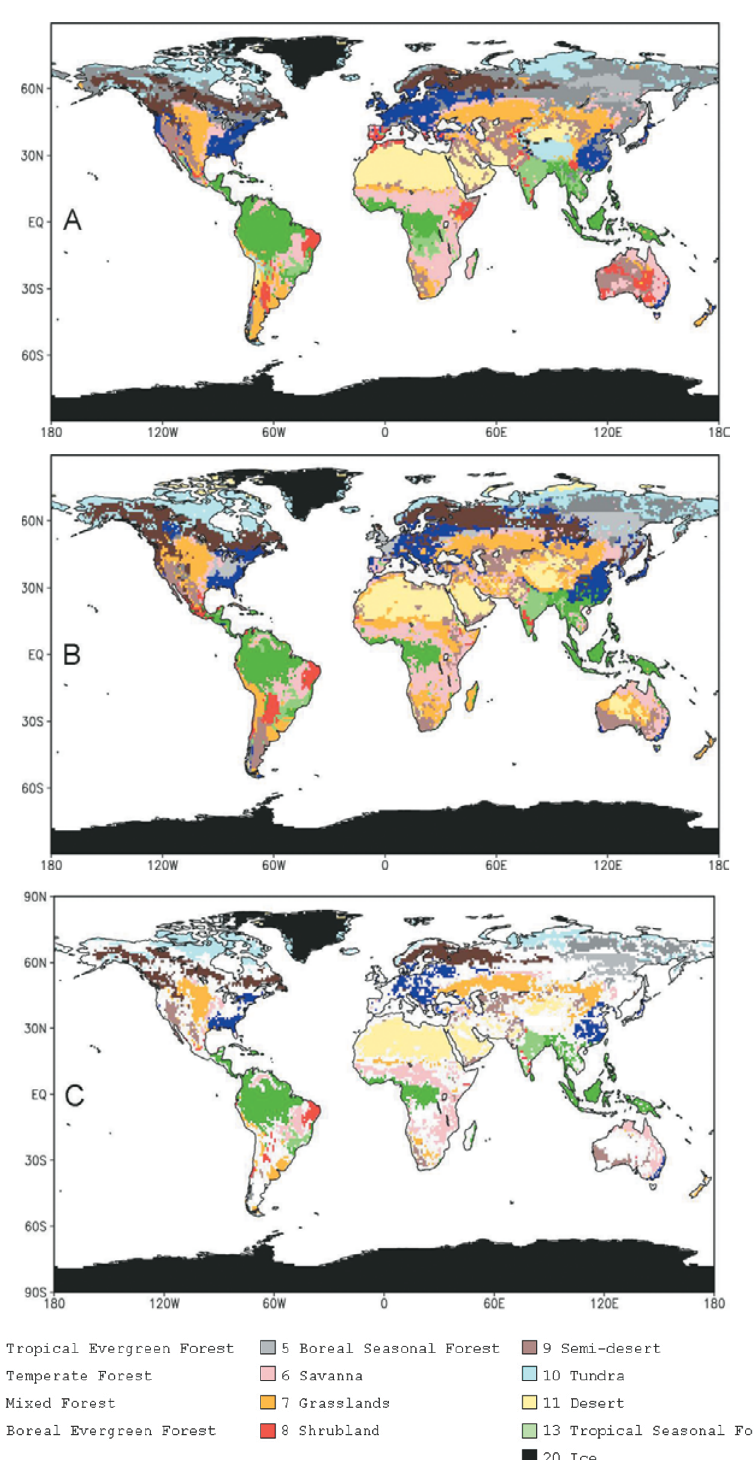
Fig. 1 – Natural vegetation maps under LONS08. (A) Ramankutty and Foley (1999), (B) Matthews (1983) and (C) consensus between them. In (C), white continental grid points represent non-consensus areas.